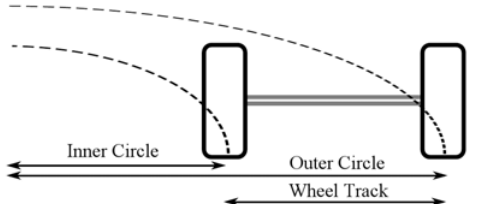
Figure 3. Manual calibration procedure to determine the wheel track length.